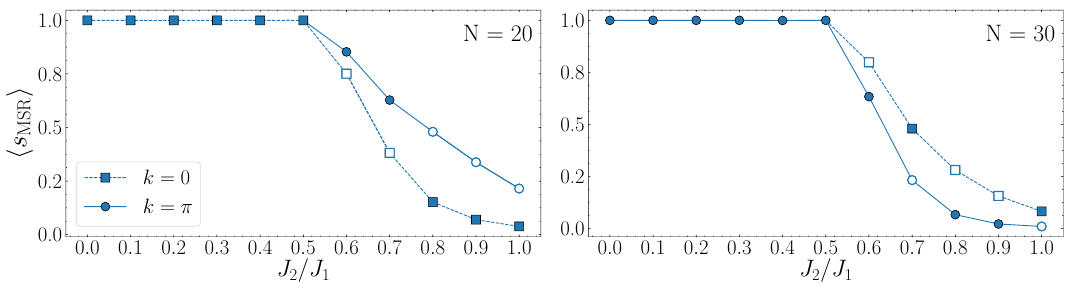
/ J for N = 20 2 1 / J < 0.5 the ground state has momentum 2 1 / J > 0.5, the momentum of the 2 1